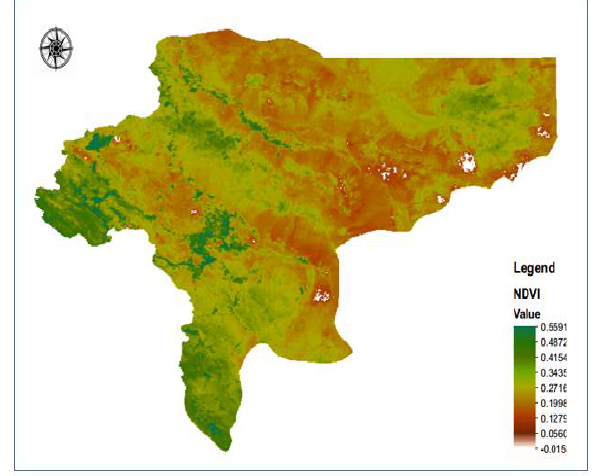
Figure3. NDVI index in July 2018